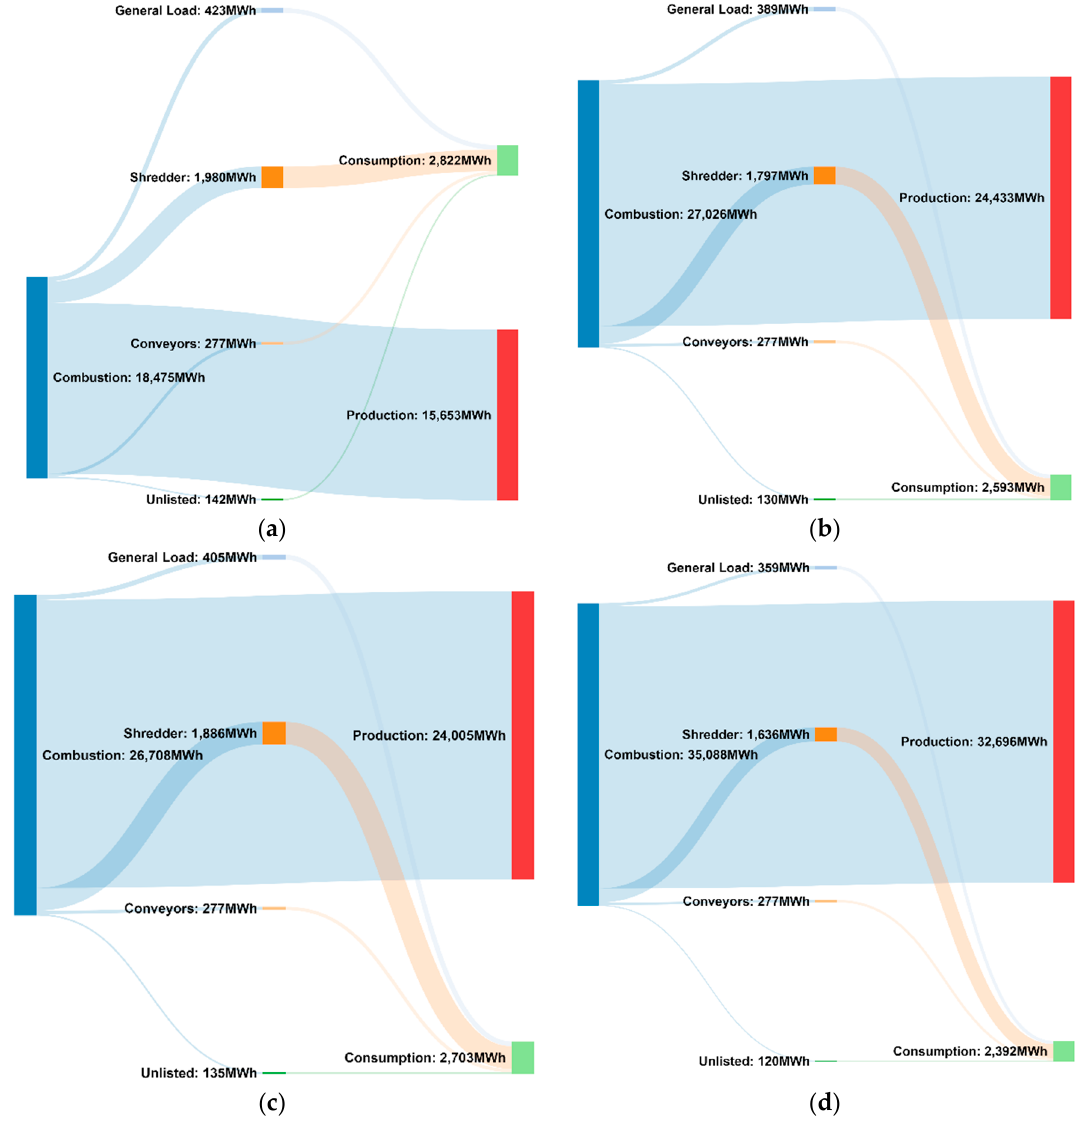
Figure 7. Energy analyses of different scenarios including consumption and production of electricity: ( a ) BGHM; ( b ) BGLM; ( c ) ECHM; ( d ) ECLM. All the numbers here are presented as MWh.